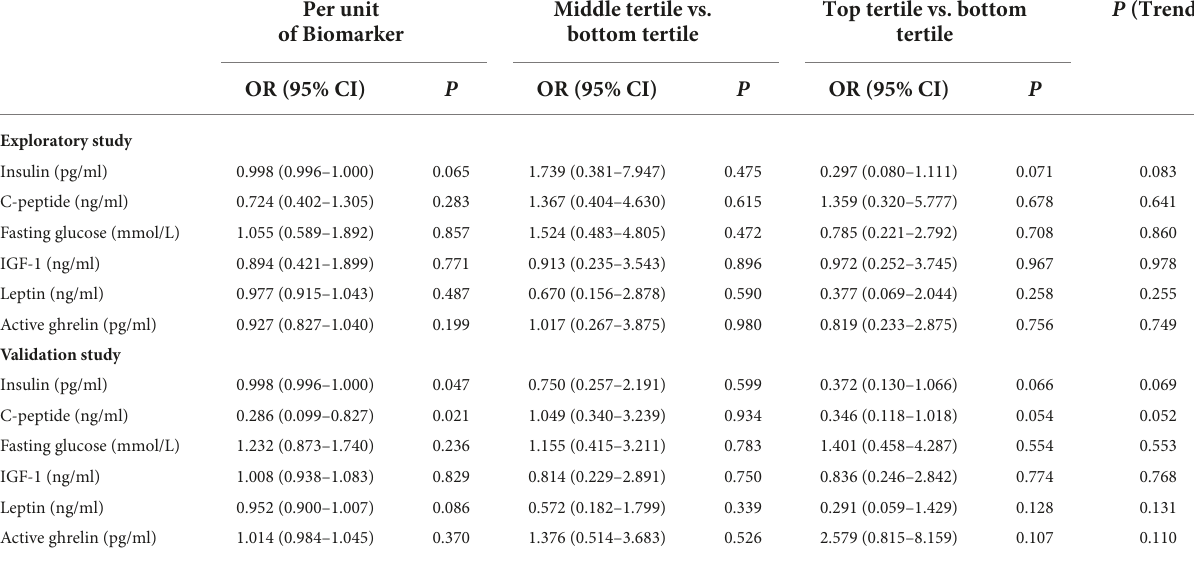
Per unit of Biomarker